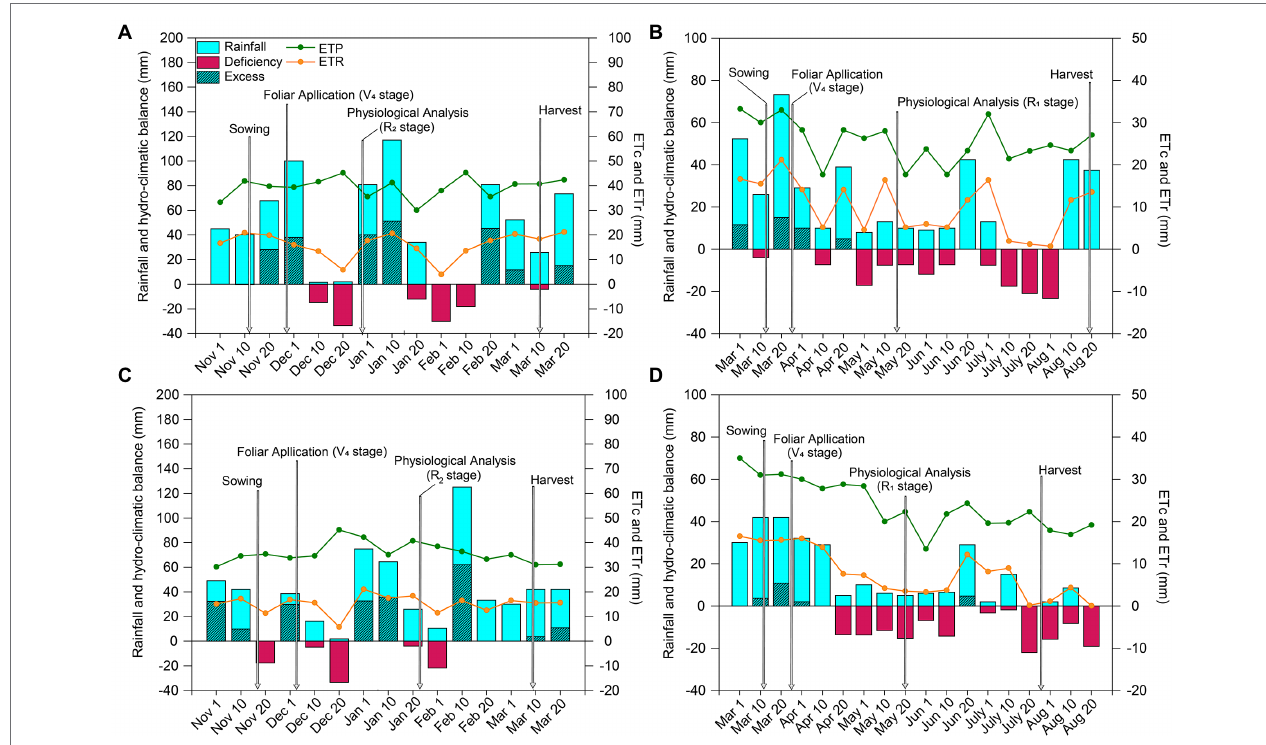
FIGURE 1 | Climatological hydroclimatic balance for soybean ( A , 2018/19; C , 2019/20) and maize ( B , 2019; D , 2020) crops grown in Botucatu, SP, Brazil. ETc: crop evapotranspiration; ETr: real evapotranspiration. Arrows indicate the timing of spraying and sampling. Different lowercase letters represent statistical difference between treatments (presence or absence of Mo) according to the F test ( p ≤